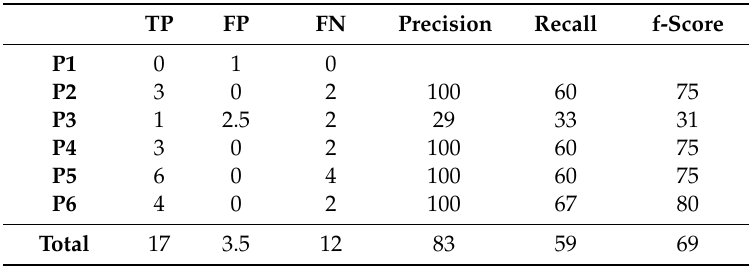
Table 4. Scores obtained with the S 2 MP